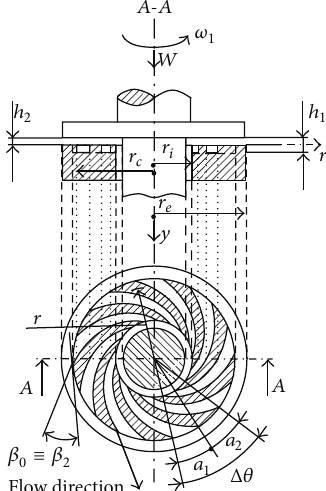
Figure 1: SATBESPIG and inner pumping. Figure 2: SATBESPIG and external pumping.